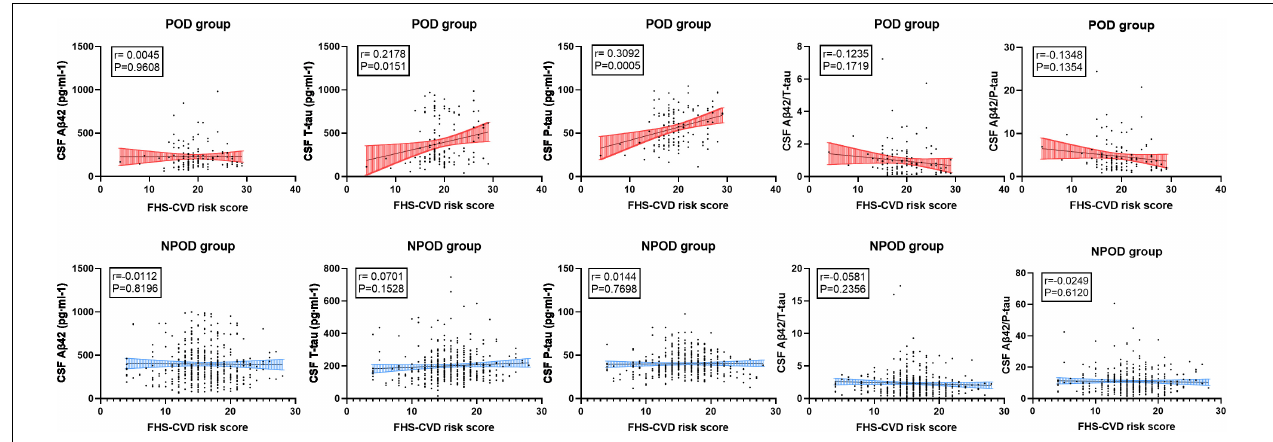
FIGURE 3 | The linear regression models showed the relationship between the CSF POD biomarkers and FHS–CVD risk score. The result showed that higher preoperative FHS–CVD risk score were positively correlated with CSF T-tau and P-tau level in the POD group. TABLE 2 | The logistic regression analysis and sensitivity analysis among FHS-CVD risk score, CSF POD biomarkers and POD. Unadjusted Adjusted1 Adjusted2 OR(95%CI) P value